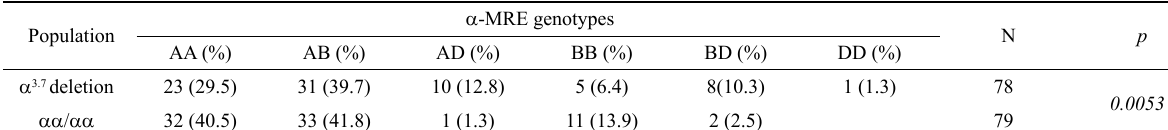
Table 2 – α-MRE genotypes in Uruguayan population with and without - a 3.7 deletion. Population